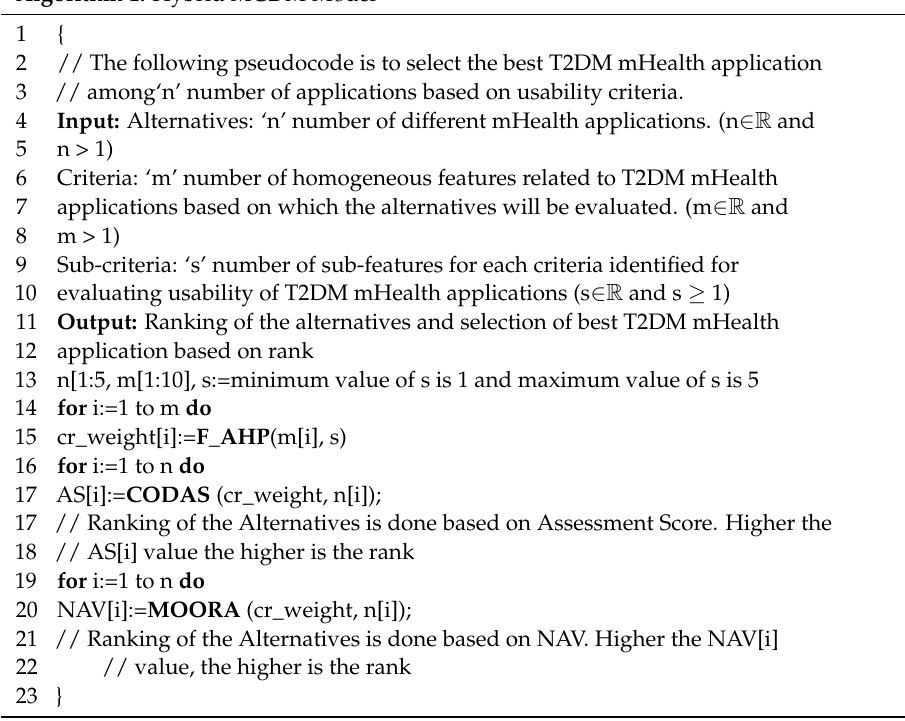
Algorithm 1: Hybrid MCDM